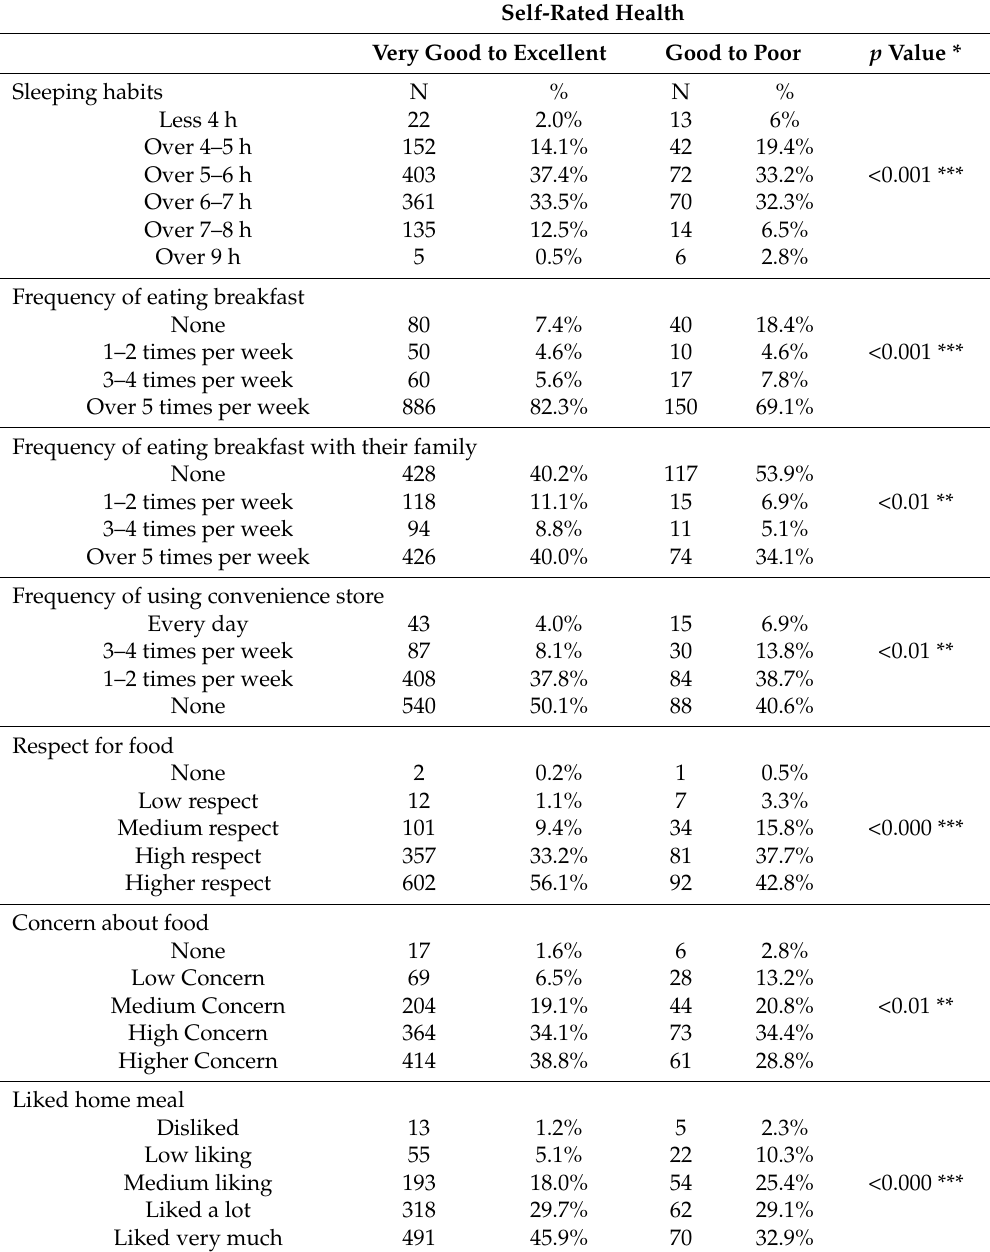
Table 2. Representative items affected by self-rated health ( n =